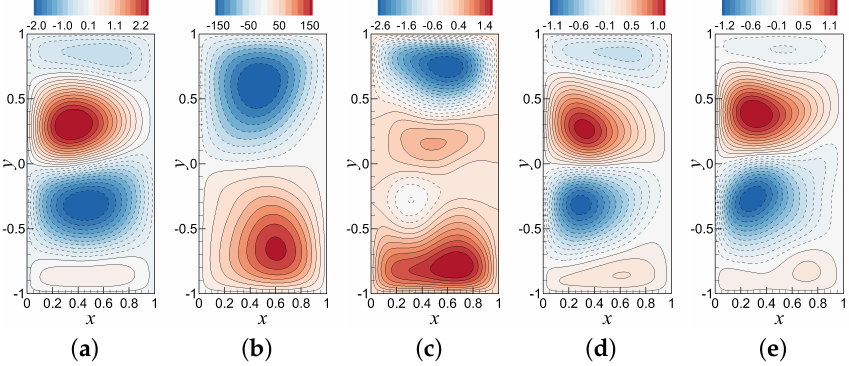
Figure 6. Mean stream function contour plots between t = 15 and t = 60 obtained by reference FOM and standard ROM-GP simulations for Re = 100: ( a ) ψ FOM at a resolution of 128 × 256; ( b ) ψ ROM-GP with R = 10 modes; ( c ) ψ ROM-GP with R = 20 modes; ( d ) ψ ROM-GP with R = 30 modes; and ( e ) ψ ROM-GP with R = 40 modes. Note that a stable and well-estimated solution can be found within R = 30 or 40 modes for this